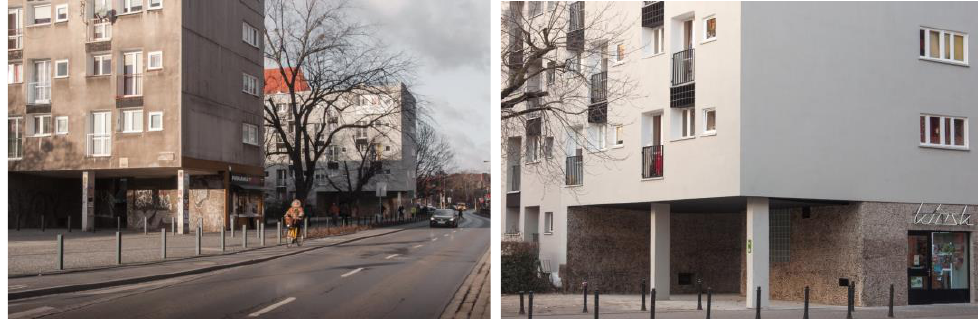
Figure 1. The blocks by Nankiera square — original and refurbished with recreated details (photography by the curtesy of Patryk Kusz /VROA Architekci).